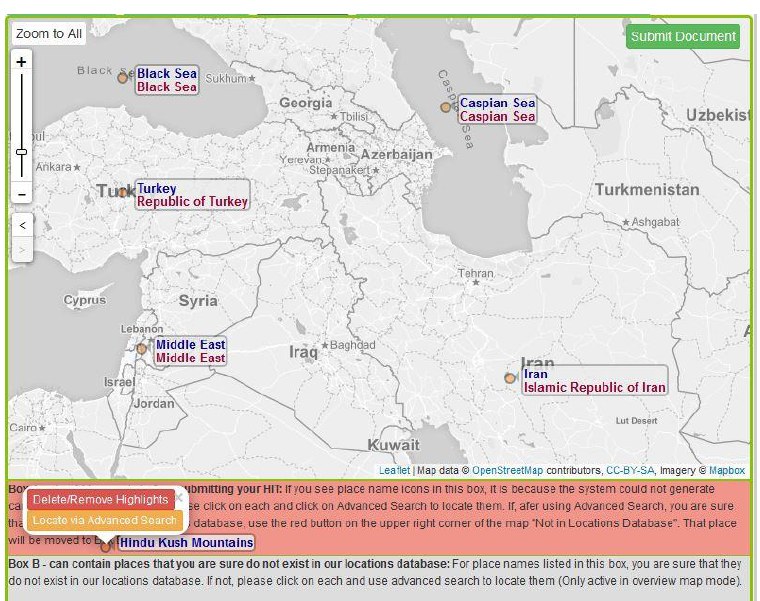
Figure 10. List of alternative toponyms for “Black Sea” displayed. The user can select one or more candidate as the ground truth toponym for a place name. If the correct toponym is not found in the list of 100 toponyms represented (in batches of 10), the user can use advanced search, accessible on the upper right corner of the map.